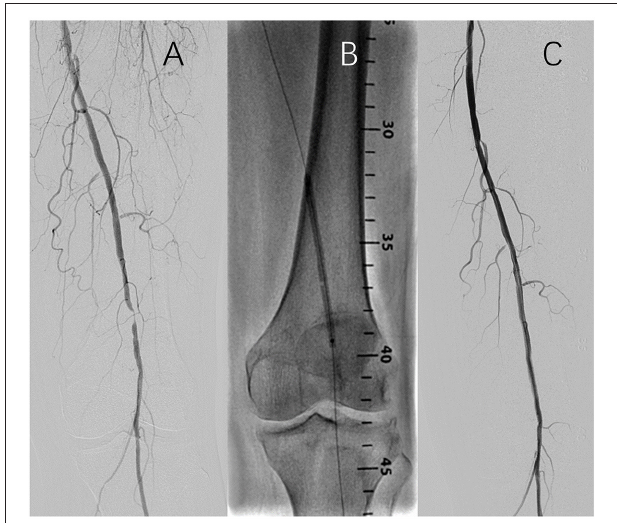
FIGURE 1 | Representitive case of the endovascular procedure. (A) Baseline angiography; (B) Balloon inflation; (C) Completion angiography.